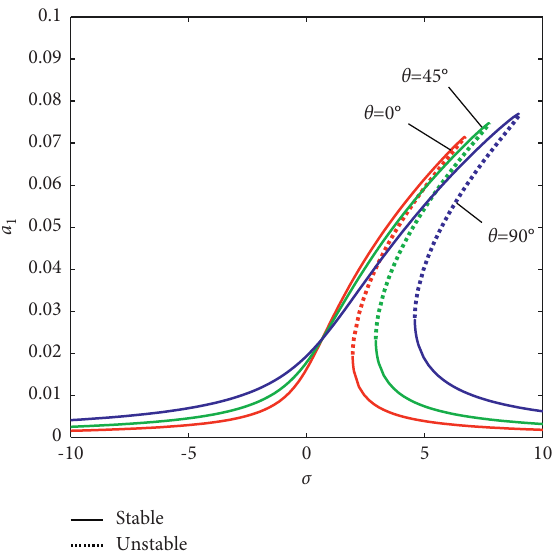
Figure 10: Amplitude versus damping coefficient with different ratios of length to diameter ( σ � 2, c � 0.01, θ � 0 ° , case